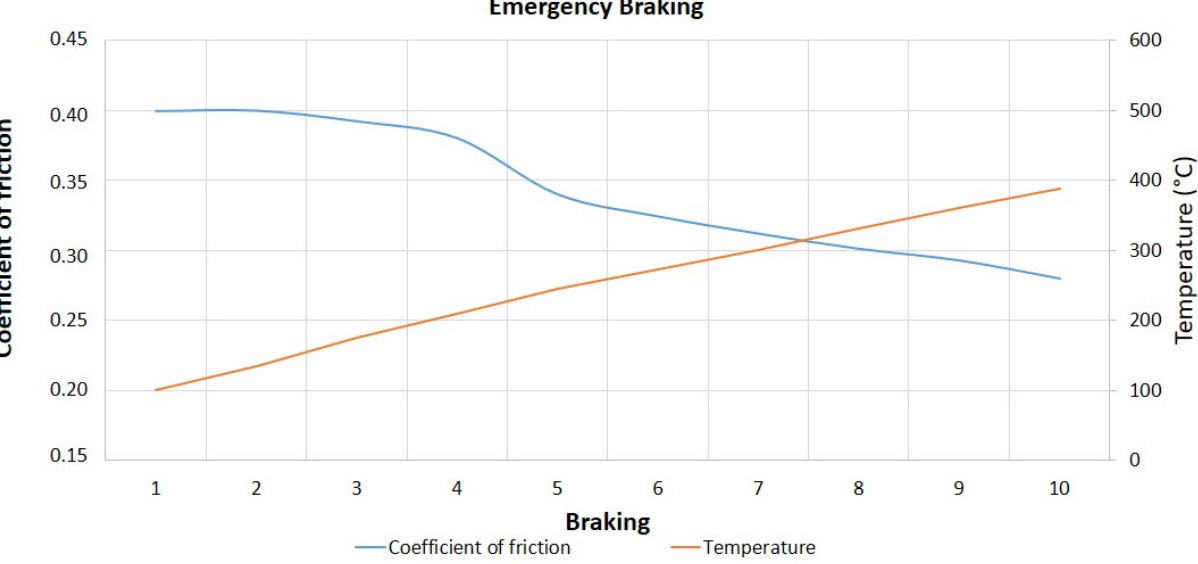
Figure 5. Coefficient of friction and temperature vs. number of brakes— Δ V = 80 Km/h.